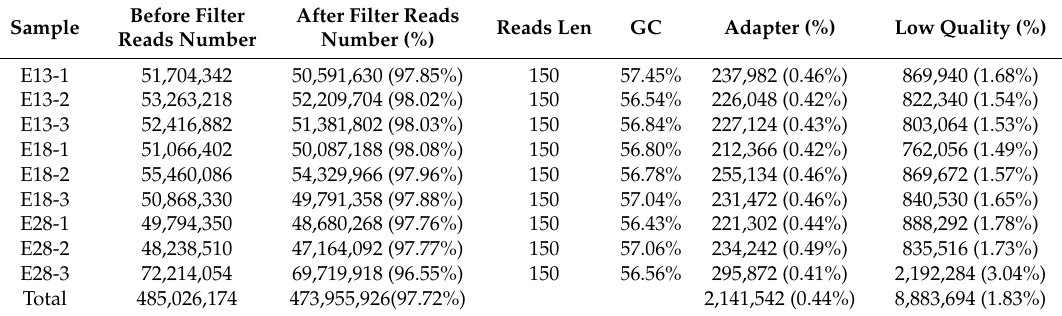
Table 1. Statistics of data filtering.